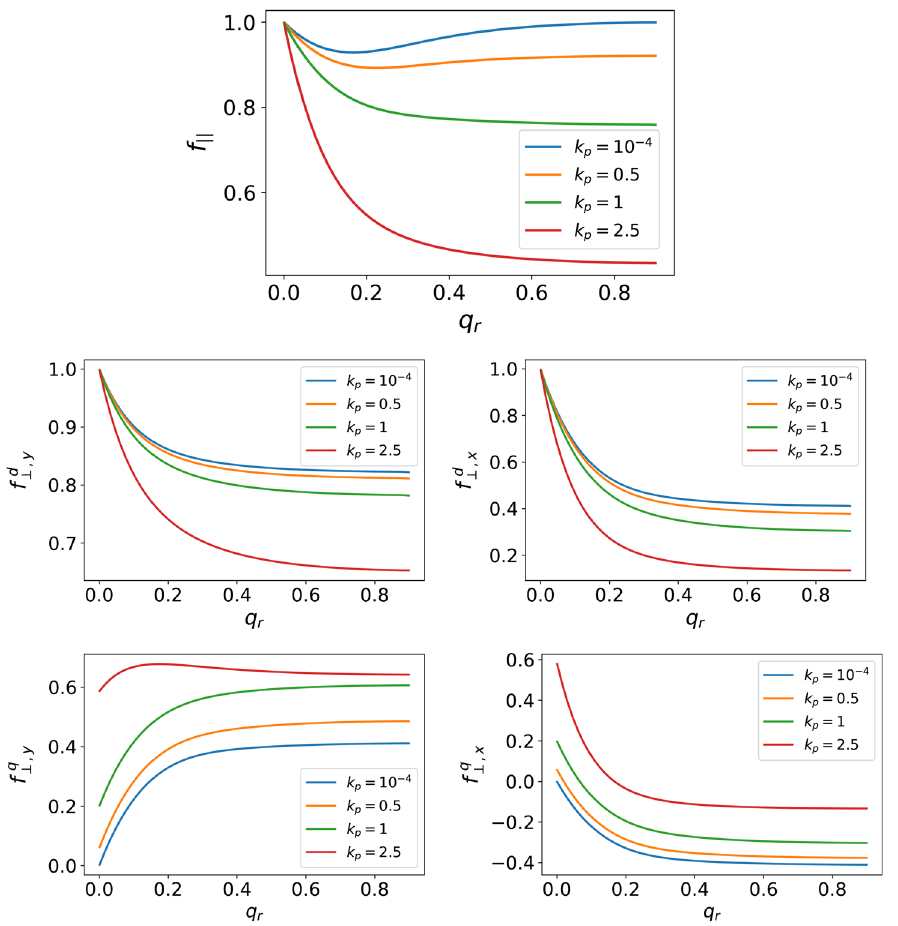
FIG. 2. Form factors as a function of q r ¼ ð a − b Þ = ð a þ b Þ for different values of k p ¼ k 0 b= ð βγ Þ